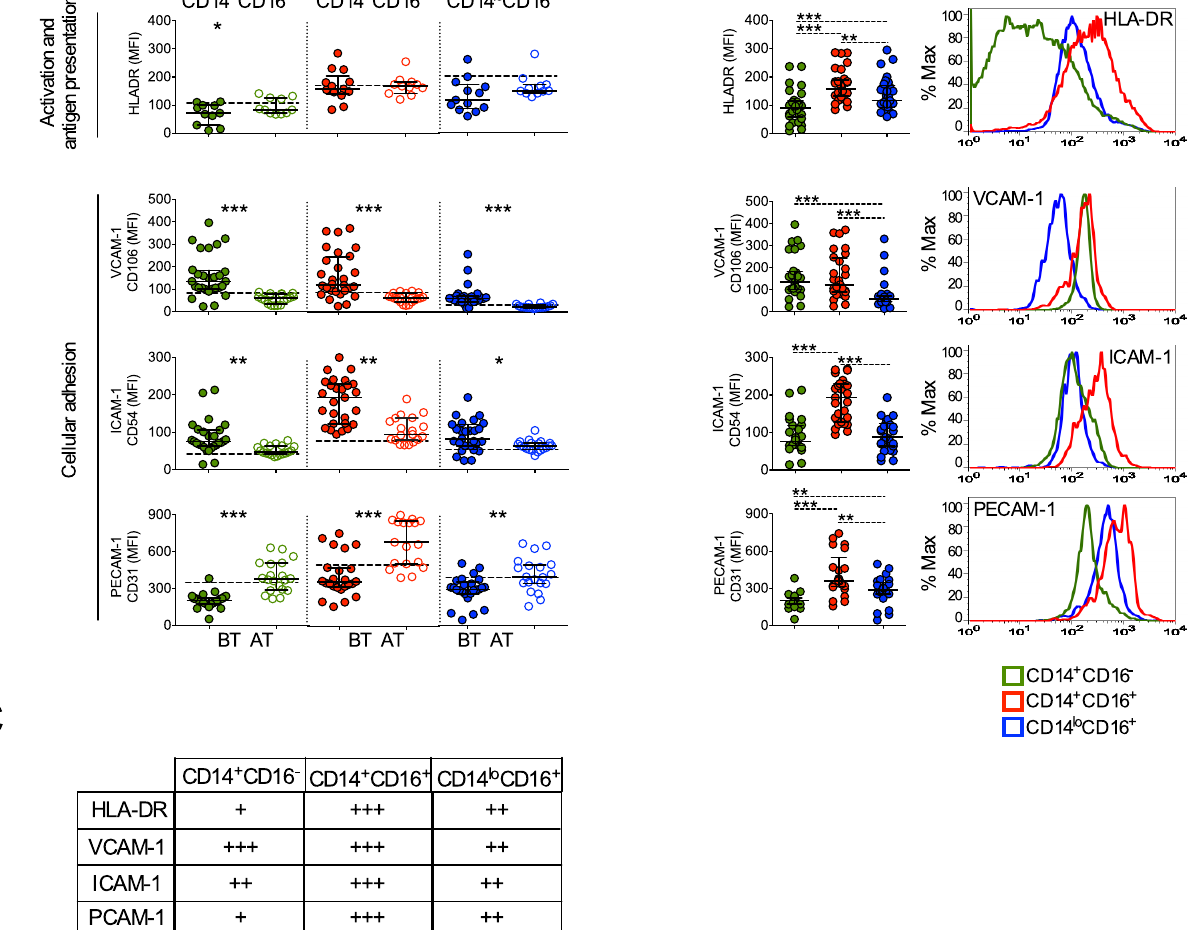
Figure 6. Monocyte subsets from P.vivax -infected patients display a highly activated phenotype. CD14 + CD16 2 , CD14 + CD16 + and CD14 lo CD16 + monocytes are represented by green, red and blue symbols. (A) Mean fluorescence intensity (MFI) of HLA-DR (BT, n=11 and AT, n=11), CD106 (BT, n=26 and AT, n=19), CD54 (BT, n=28 and AT, n=19) and CD31 (BT, n=25 and AT, n=20) (from the top to the bottom) was evaluated on monocyte subsets (CD14 + CD16 2 (left panel), CD14 + CD16 + (middle panel), CD14 lo CD16 + (right panel)) from P. vivax -infected subjects, before (filled symbols) and 30–45 days after treatment (open symbols). Dotted lines represent medians of given measurements from healthy donors. (B) Scattered dot plots (left panels) and representative histograms (right panels) showing MFI of the molecules described above on CD14 + CD16 2 , CD14 + CD16 + and CD14 lo CD16 + monocytes from P. vivax -infected patients before treatment. Levels of the molecules above were measured by flow cytometry. Circles indicate individual patients and lines represent median values and interquartile ranges. (C) Levels of molecules expressed by the monocyte subsets analyzed according to B. * p , 0.05, **0.05 . p . 0.01, *** p , 0.01. proportions of monocyte subsets were detected when PBMC were cultured for 4 and 12 hours in medium or Pv-Ret (Figure S2) (Text S1).